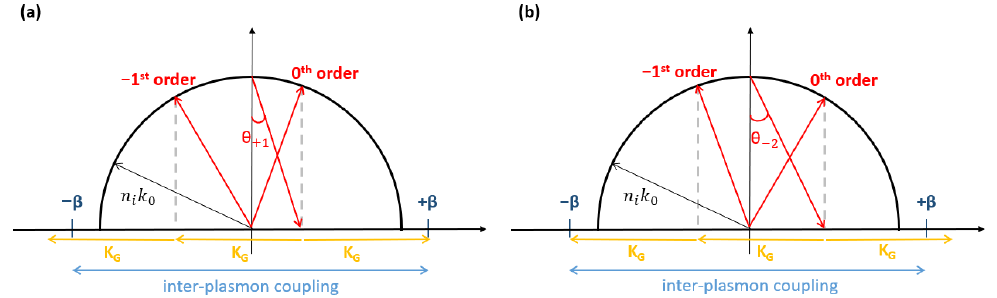
Figure 2. ( a ) Co-directional and ( b ) contra-directional coupling schemes, illustrating diffraction and SP interaction processes. θ + 1 and θ − 2 are the angles of the incident beam. K G stands for the grating wavenumber (momentum). + β and − β denote the propagation constants associated with the forward and the backward SPs, respectively. n i and k 0 represent the RI of the sensing medium and the wavenumber of the incident beam, respectively.